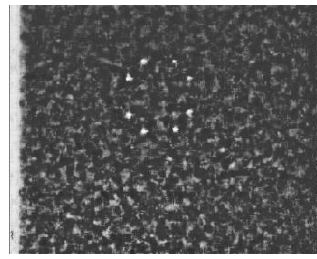
K . Figure 11 shows the image intensity dynamic piecewise nonlinear adjustment results.